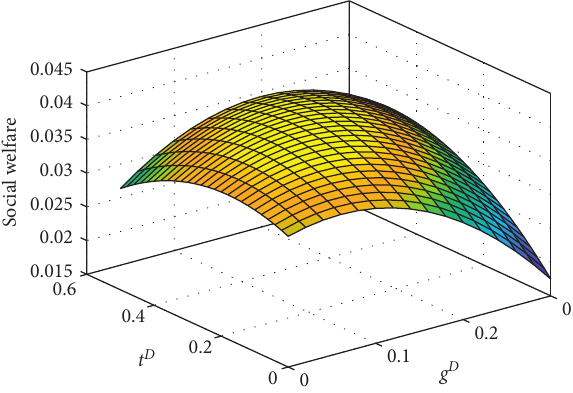
Figure 11: The impact of t D and g D on total social